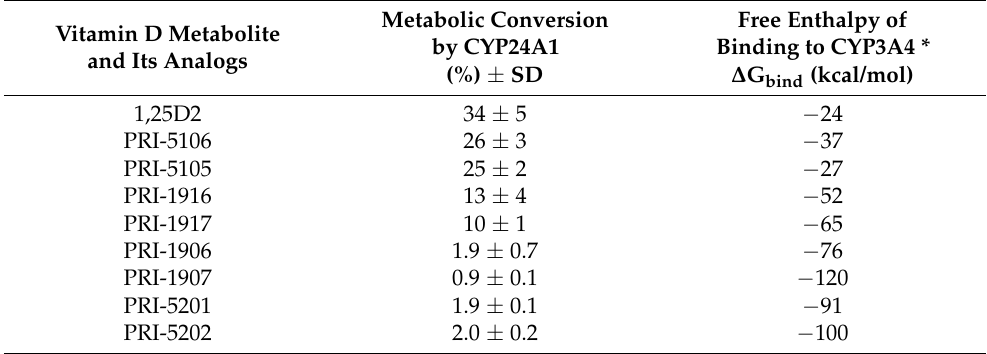
Table 1. The experimental metabolic conversion of 1,25D2 and its analogs by CYP24A1 [10,16,41] and the calculated free enthalpy of binding to CYP3A4. Vitamin D Metabolite and Its Analogs